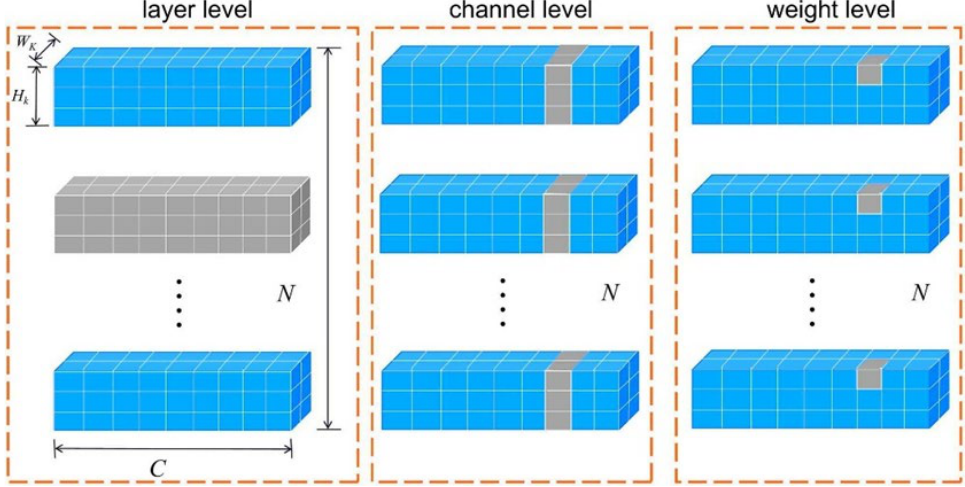
Figure 4. Visualization of different types of pruning (gray part represents pruning